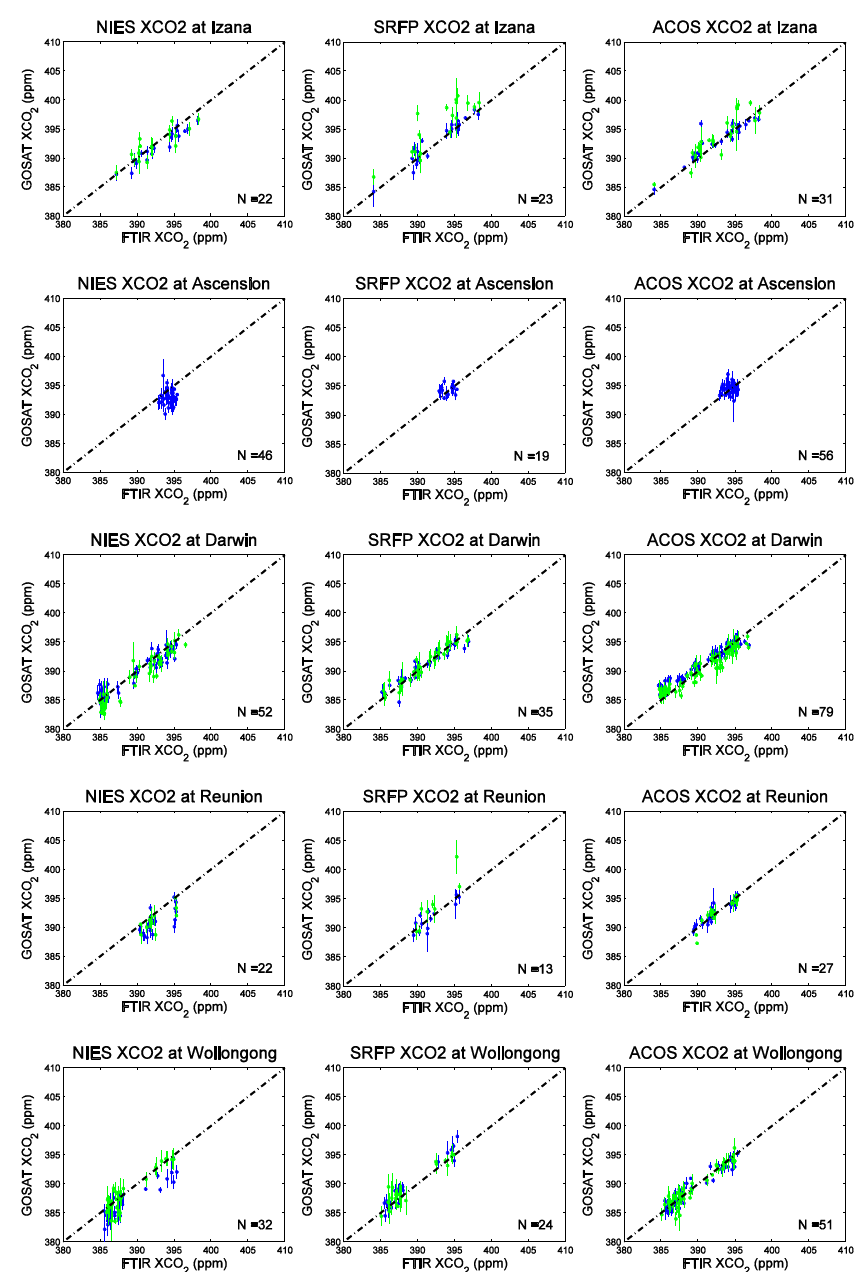
Figure 5. The scatter plots of daily median of XCO 2 from FTIR measurements and different GOSAT algorithms retrievals over 5 TCCON sites. Only the ocean and land data co-existing within ± 1 day are selected; N is the total number of days. The error bar represents the standard deviation of all the measurements within ± 1 day. The blue and green points present the glint mode over ocean and the normal nadir mode above land,